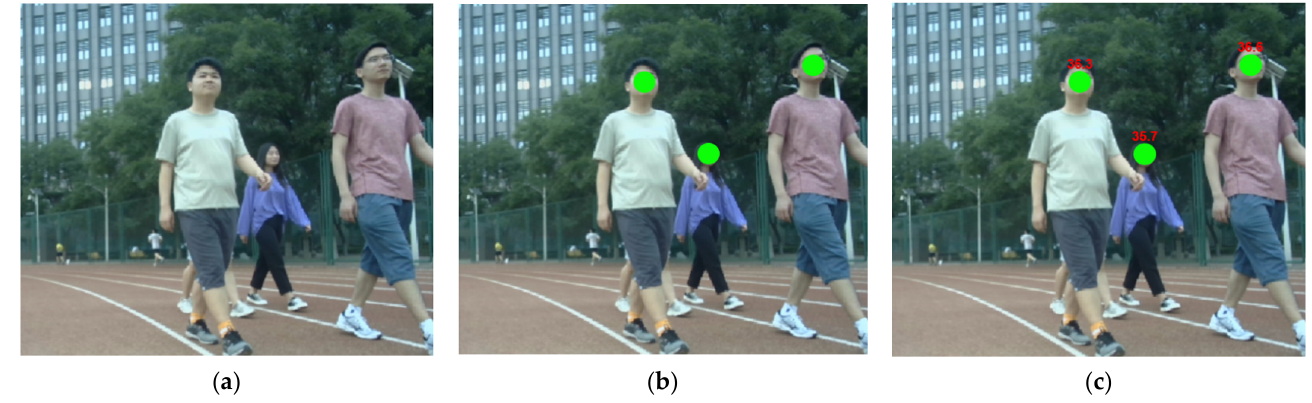
Figure 16. Results of temperature detection. ( a ) Original image. ( b ) Face detection. ( c ) Temperature detection.